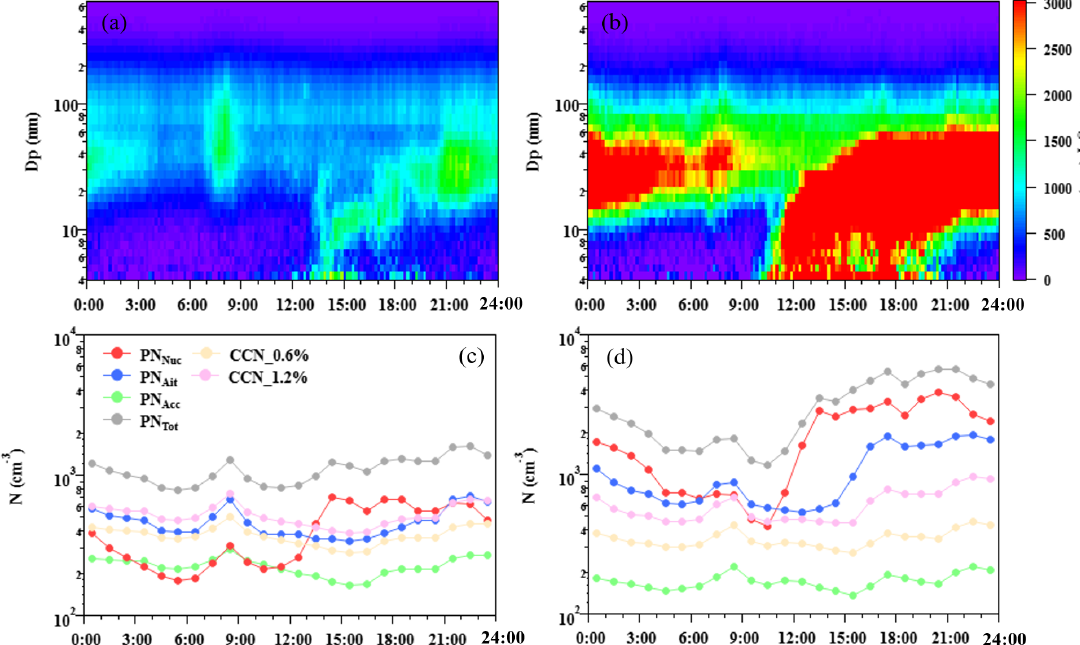
Figure 9. Diurnal variations of particle number size distributions (PNSDs) and the number concentrations of nucleation mode particles (PN Nuc ), Aitken mode particles (PN Ait ), accumulation mode particles (PN Acc ), the total particles (PN Tot ), CCN at S c of 0.6% (CCN_0.6%) and 1.2% (CCN_1.2%) during the pre-monsoon (a, c) and monsoon (b, d)